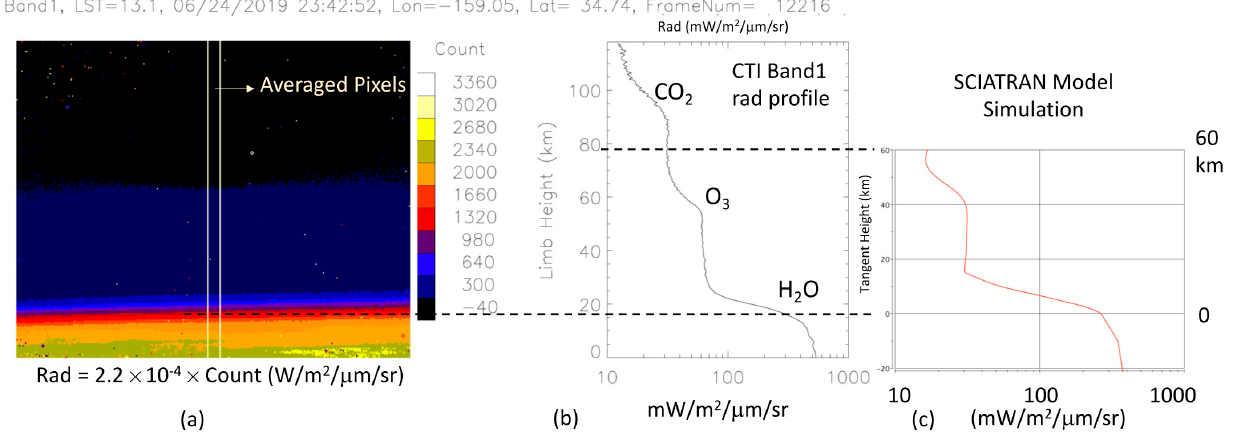
approximate surface and the 60 km tangent height.